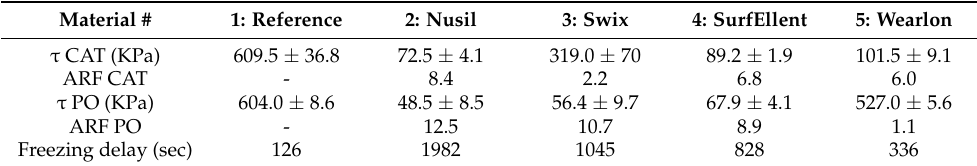
Table 2. Icephobic